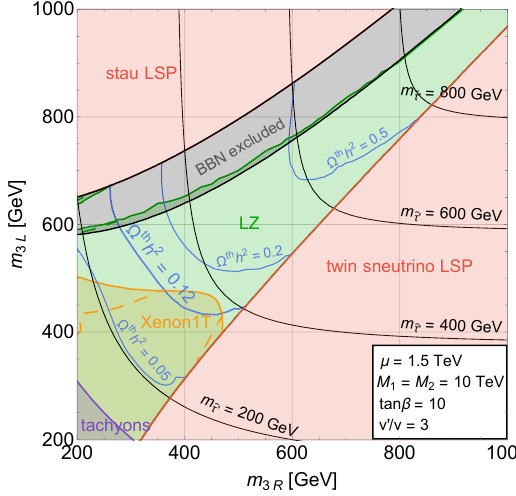
Figure 3. Contours of Ω th h 2 (blue lines) and the lightest twin stau mass (black line) in the plane of the right and left soft stau masses ( m , respectively) for µ = 1 . 5 TeV, tan β = 10 , 3 R , m 3 L v 0 /v = 3 and the bino and wino mass parameters M 1 = M 2 = 10 TeV. In the purple region there are tachyons in the spectrum and in the red regions ˜ τ 0 is not the LSP. The yellow (green) region denotes the area excluded (probed) by Xenon1T (LZ) assuming that Ω 2 = 0 . 12 in every point of ˜ τ 0 h the plane. The dashed curves instead assume the scaling of the bound with the thermal abundance if Ω 2 = Ω th h 2 < 0 . 12 which corresponds to the case in which twin stau is only sub-component ˜ τ 0 h of the total